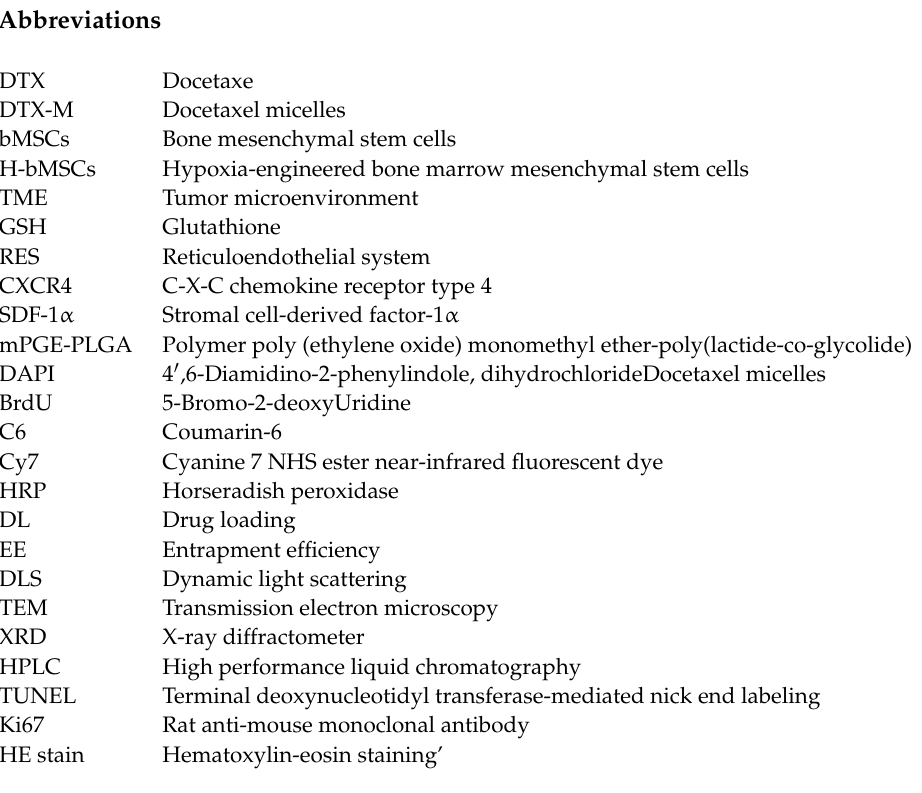
concentration. Table S2: Drug loading of the complexes with 40 µ M DTX concentration at different times. Figure S1: Drug loading of the complexes at different times. Figure S2: The zeta potential of DTX-M and blank micelles. Figure S3: Identification of the bMSCs isolated from BALB/c mice by flow cytometry. Figure S4: Flow cytometry analysis of cellular uptake ability at different co-incubation time. Figure S5: Flow cytometry analysis of the release behavior from H-bMSCs or